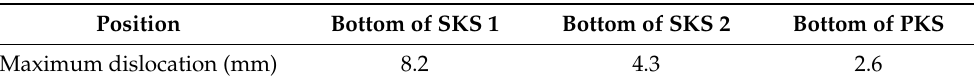
Table 3. Maximum dislocation of the 1# borehole at the bottom of the three key strata (KS).